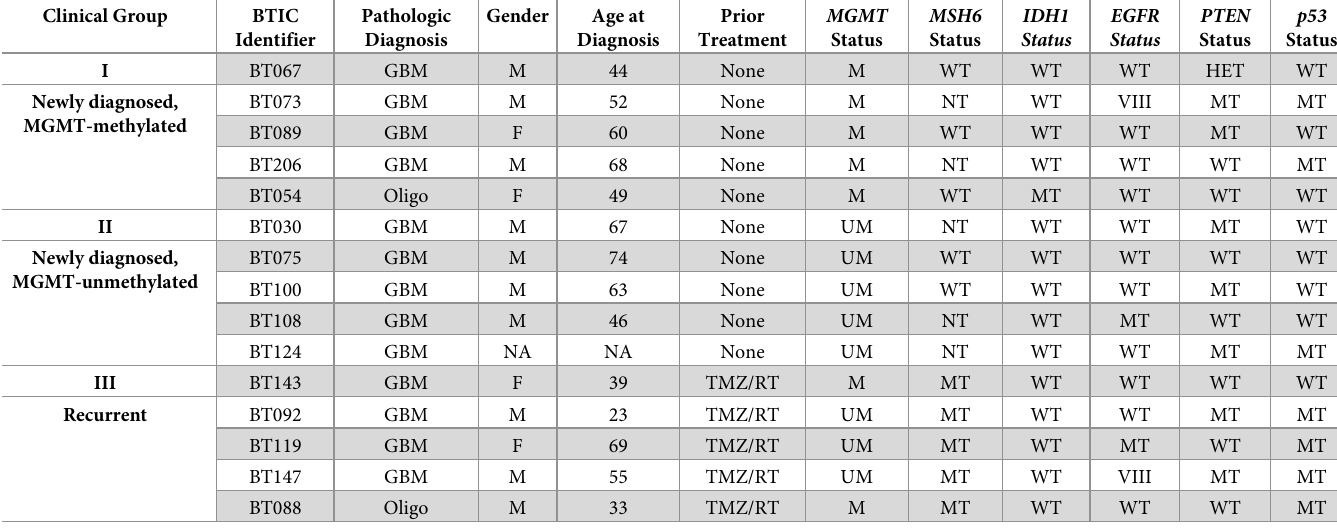
Table 1. Description and clinical subgroups of the patient-derived